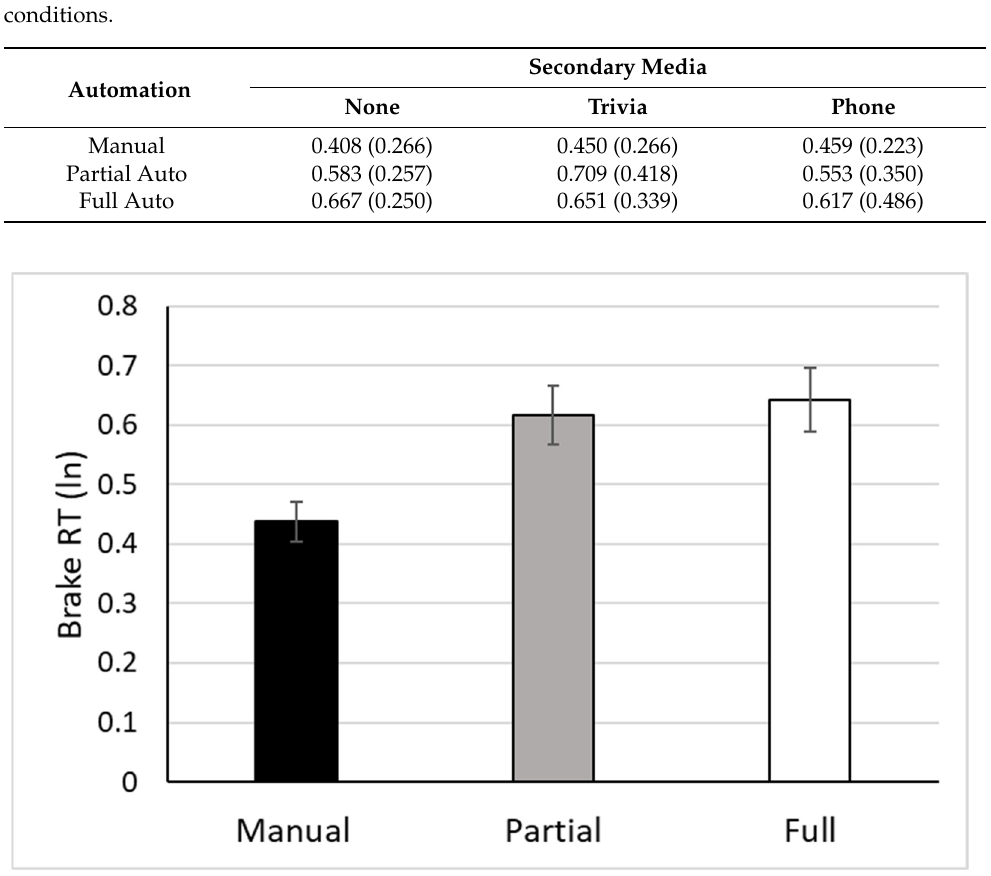
Figure 5. Mean braking RT in three automation conditions, averaged across secondary media conditions. Error bars are standard errors.